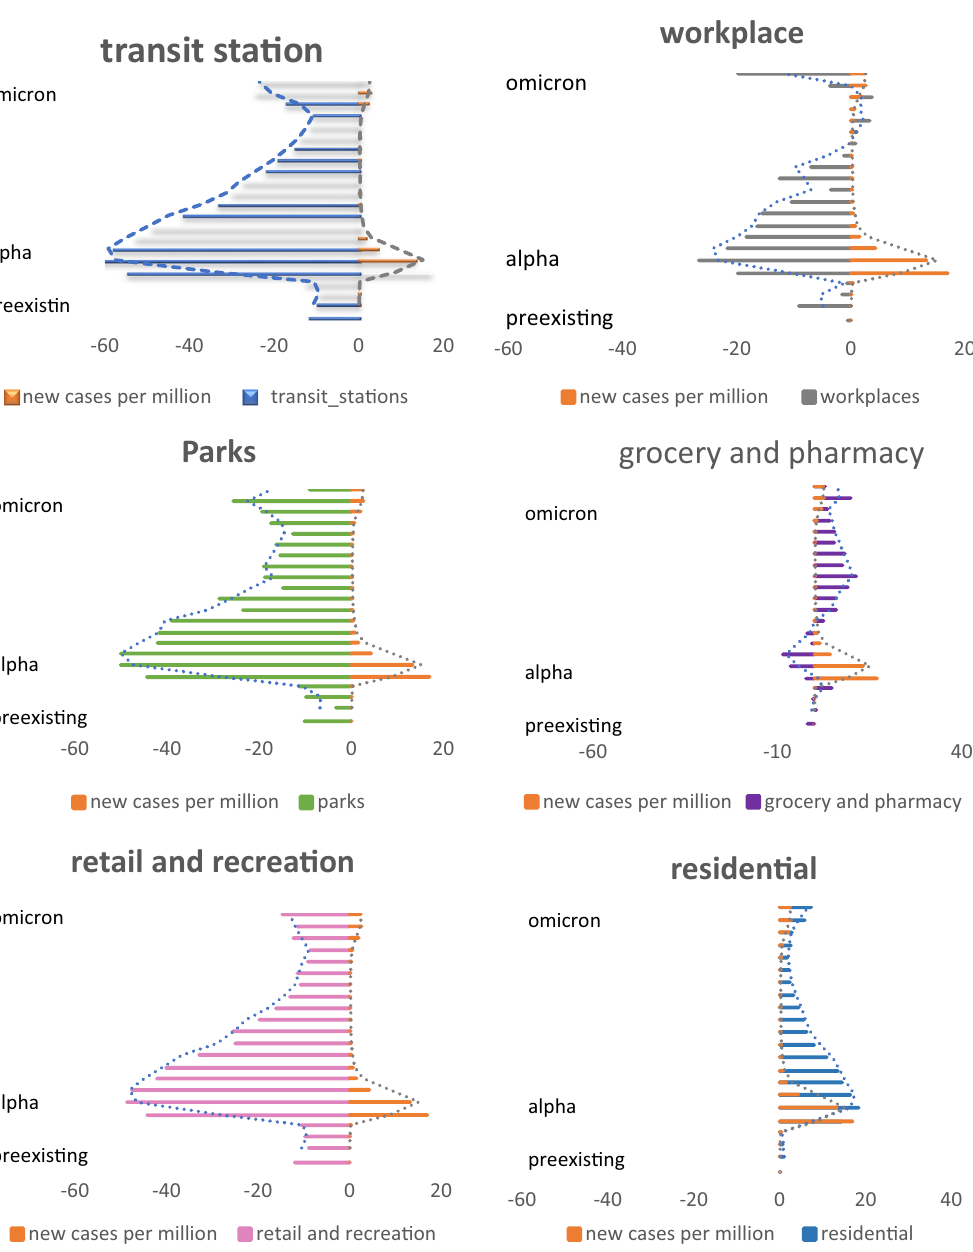
Figure 1. Changes in population mobility at various places during the pre-existing. Alpha, and Omicron variant